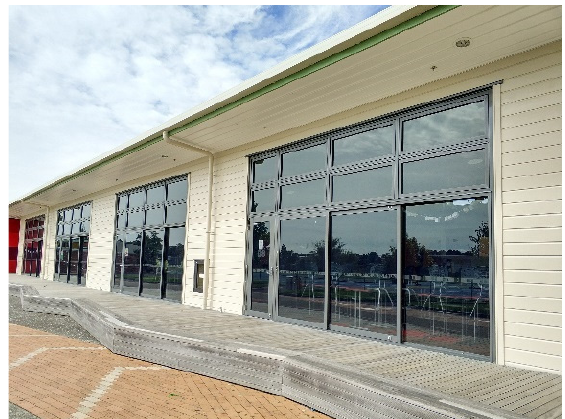
Figure 2. Retrofit school building.